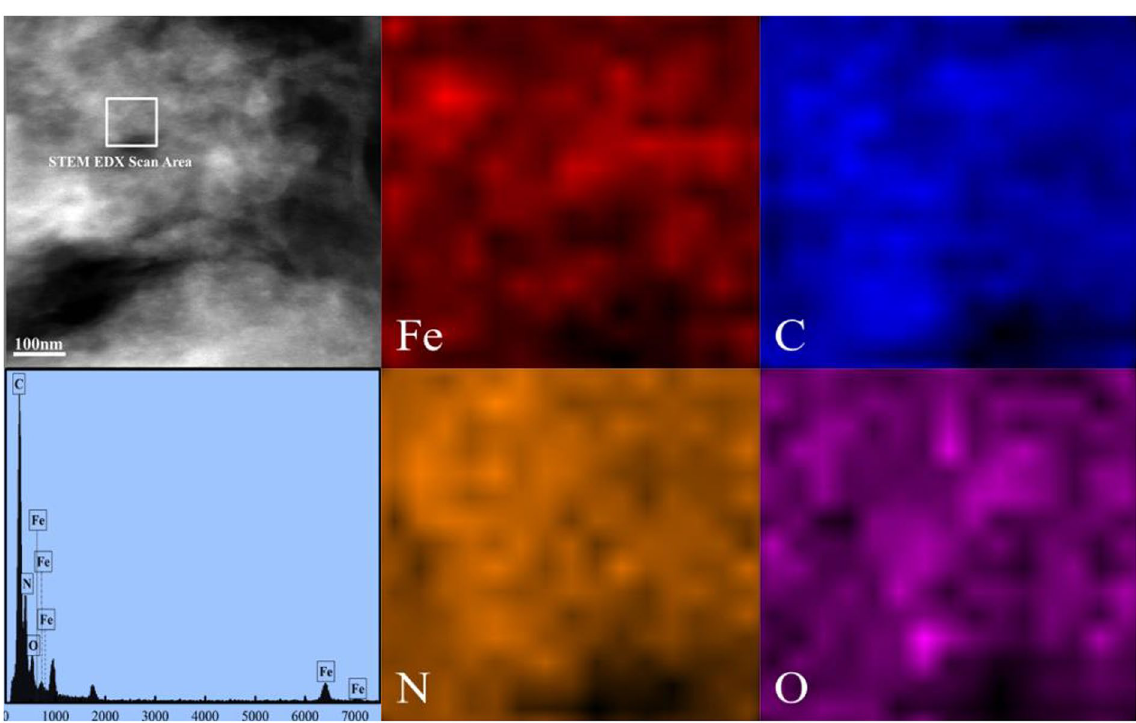
Figure 8. The elemental mapping images and EDX spectrum of the a-FeOOH/CNNS-800